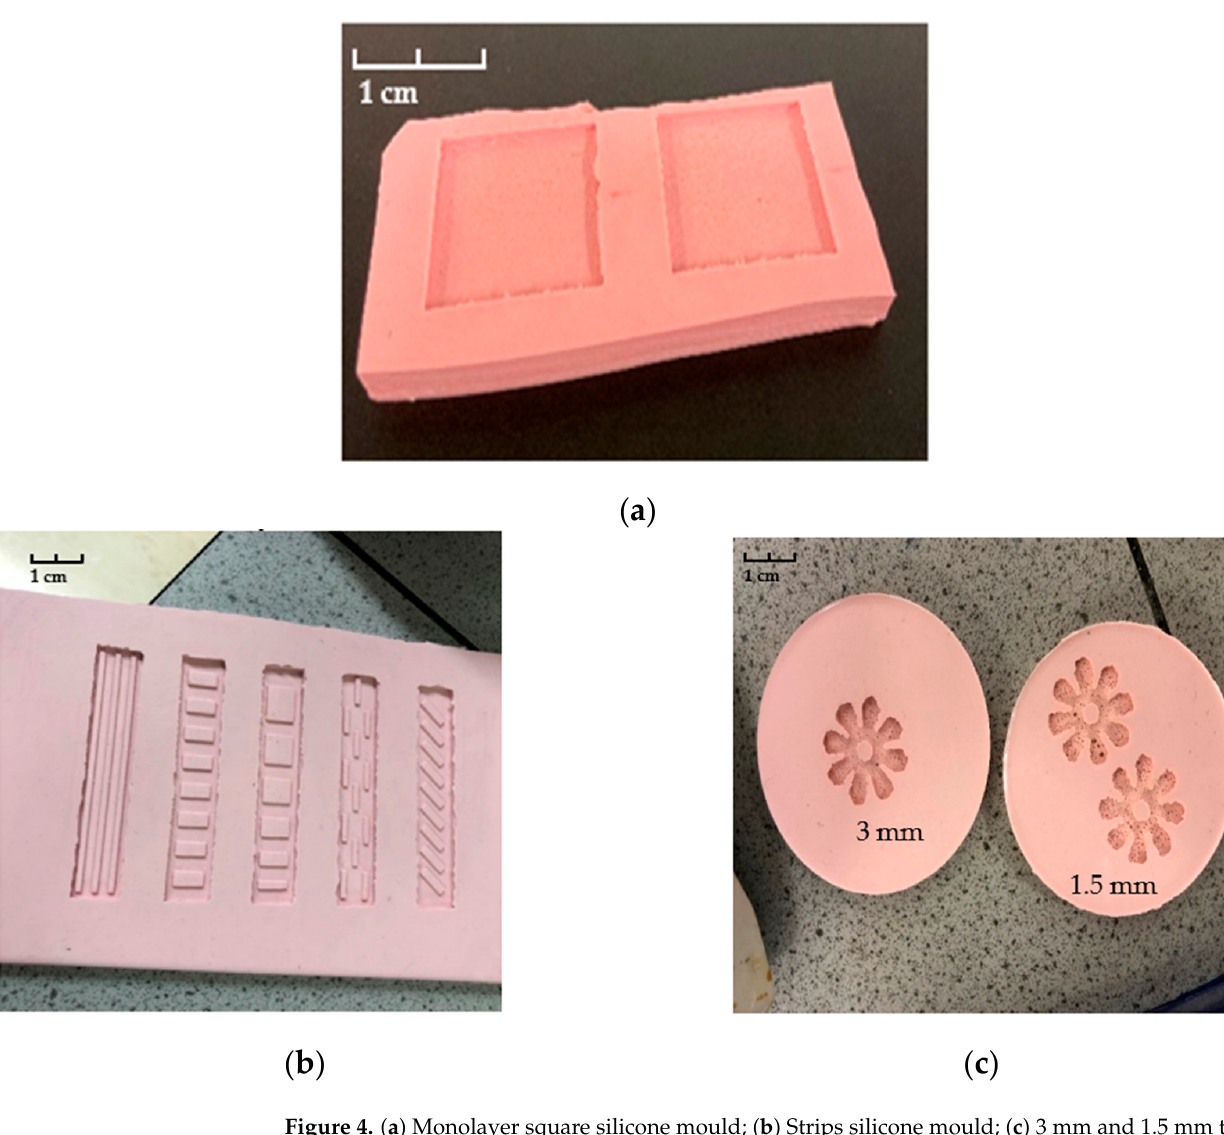
Figure 4. ( a ) Monolayer square silicone mould; ( b ) Strips silicone mould; ( c ) 3 mm and 1.5 mm thick flower silicone moulds.